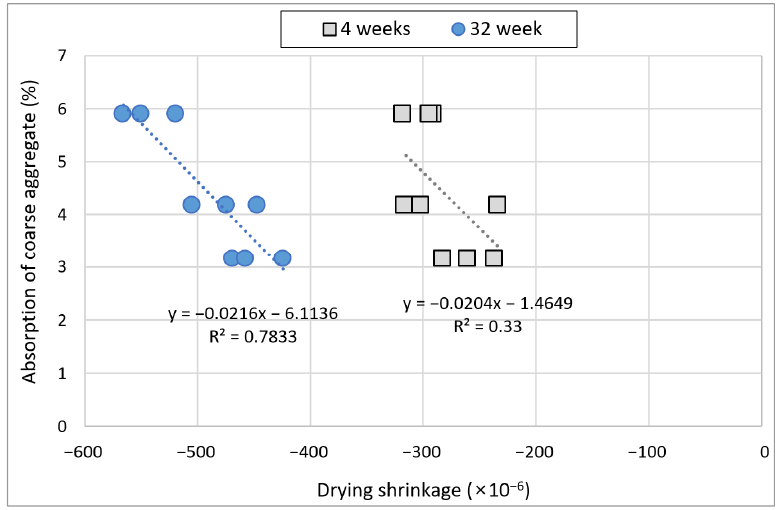
Figure 13. Relationship between drying shrinkage and absorption of coarse aggregate.